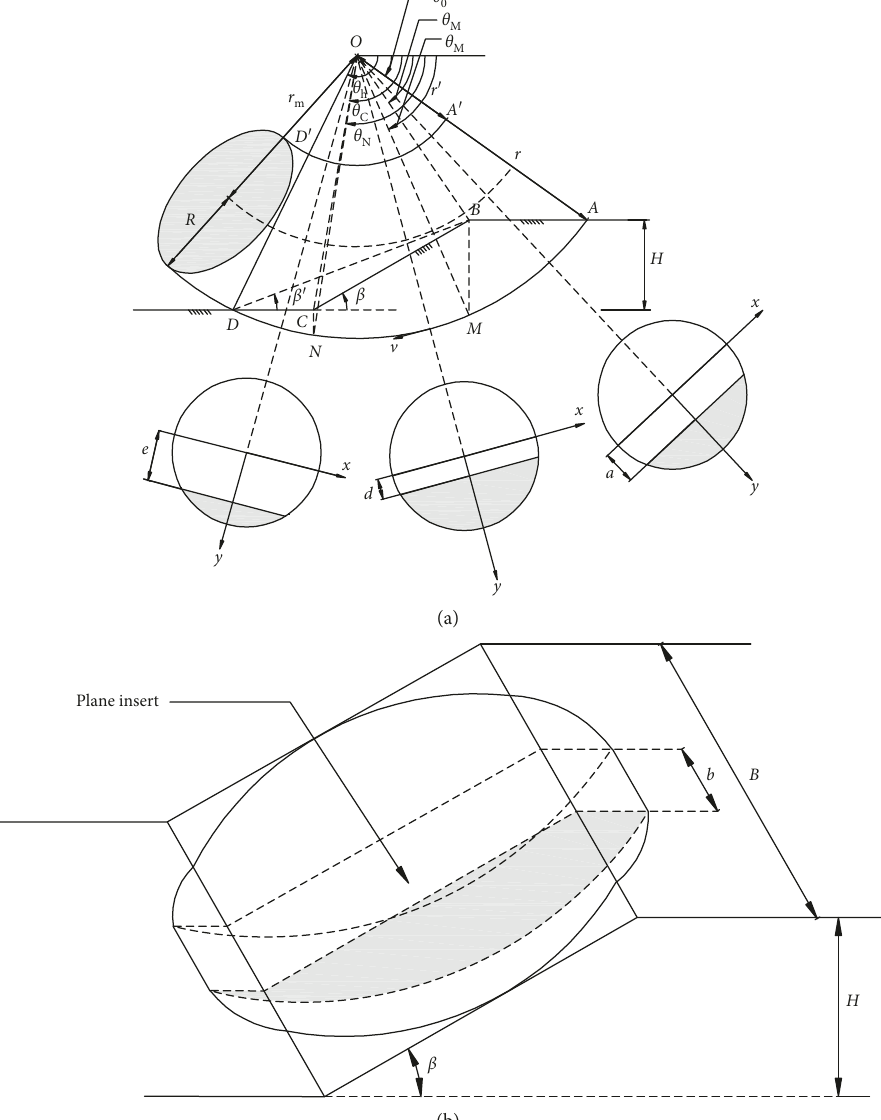
Figure 2: 3D failure mechanisms for undrained slopes: (a) torus-type failure surface; (b) failure surface with limited width B (adopted from the study of Michalowski and Drescher,